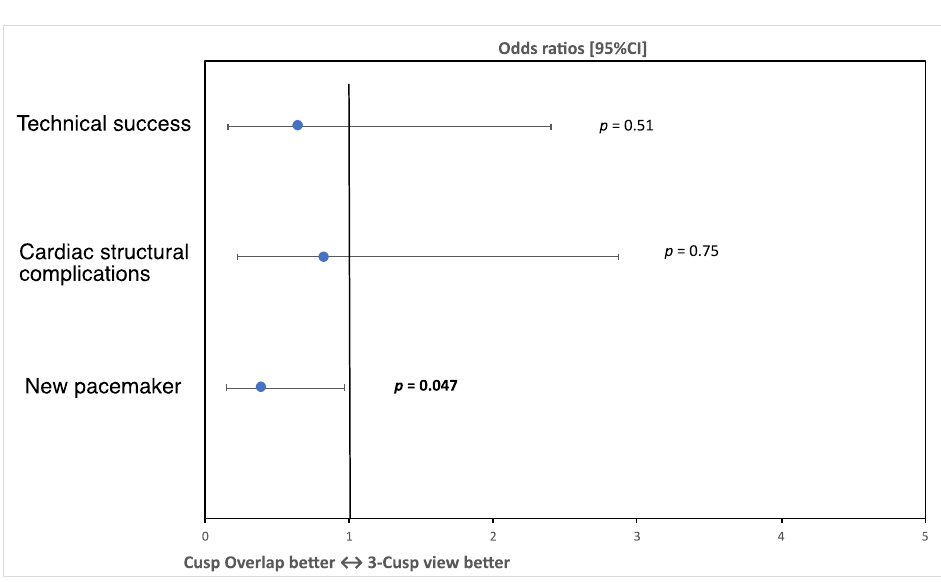
Figure 3. Primary and secondary endpoints: this figure displays the odds ratios and 95% confidence intervals for primary and secondary endpoints showing a significant difference regarding the risk for permanent pacemaker implantation. Table 3. In-hospital VARC-3 endpoints. This shows procedural endpoints in COP and TCV patients.